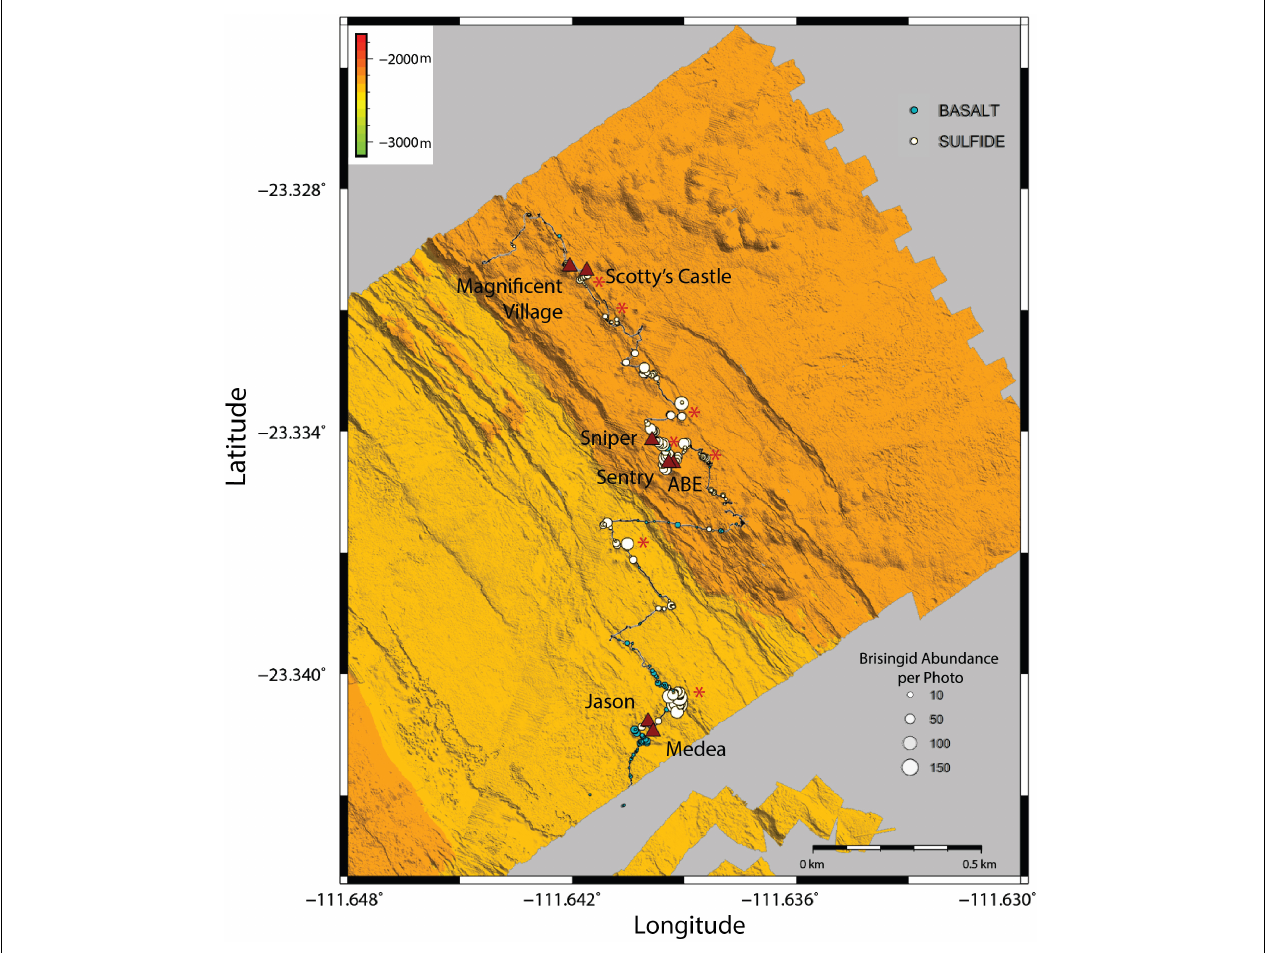
FIGURE 6 | ROV Jason II Dive 961 navigation track overlain with brisingid abundance (per photo) bubble plots for basalt and hydrothermally inactive sulfide substrata. Labeled triangles indicate locations of active black smokers; asterisks indicate aggregations of relict sulfide